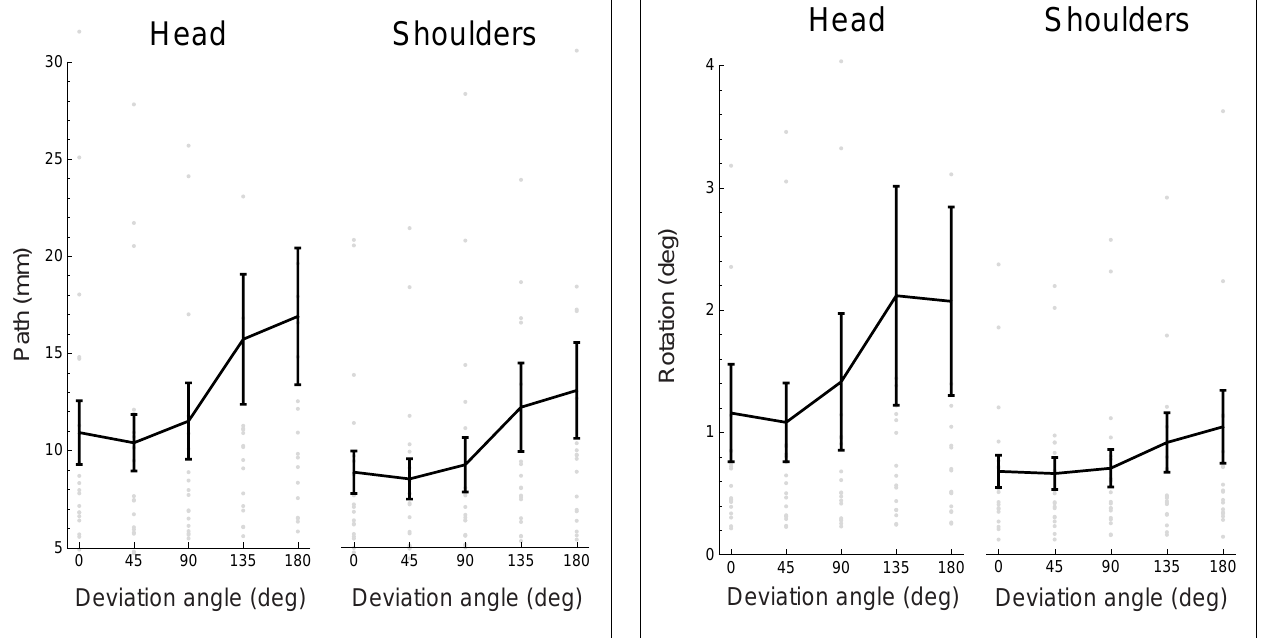
FIGURE 6 | Mean path length traveled by the head and shoulders as a function of deviation angle. Gray dots represent individual participants’ data, the black curve the mean, and error bars between-subject SE. Several outlying datapoints are not shown.